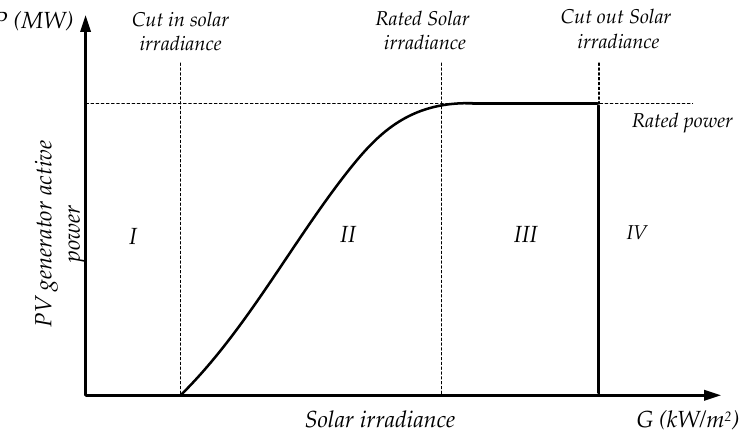
Figure 7. Control areas of a PV generator in a Power vs Solar irradiance curve (P-G